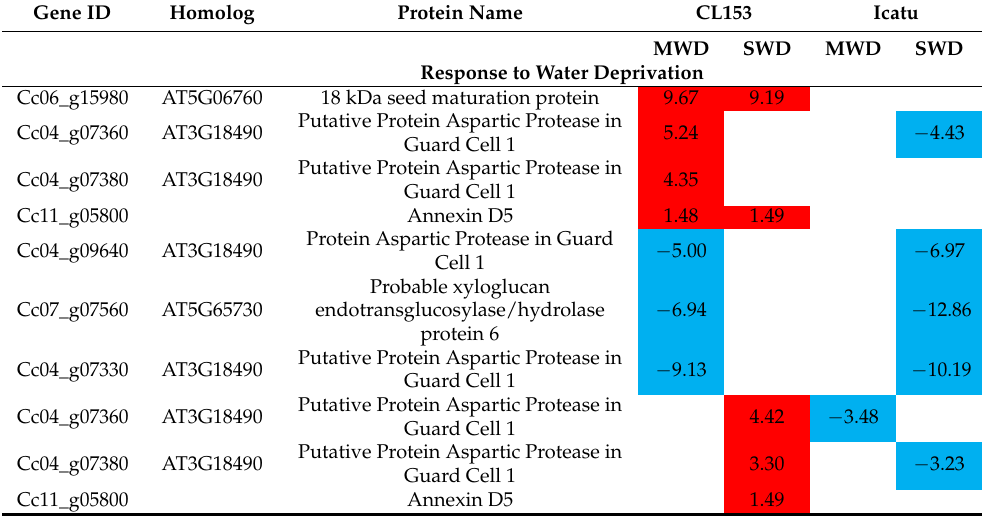
Table 5. Differentially expressed genes (DEGs) under moderate water deficit (MWD) or severe water deficit (SWD) relative to well-watered (WW) C. canephora cv. Conilon Clone CL153 (CL153) and Coffea arabica cv. Icatu (Icatu) plants. Selected DEGs were annotated with the Gene Ontology